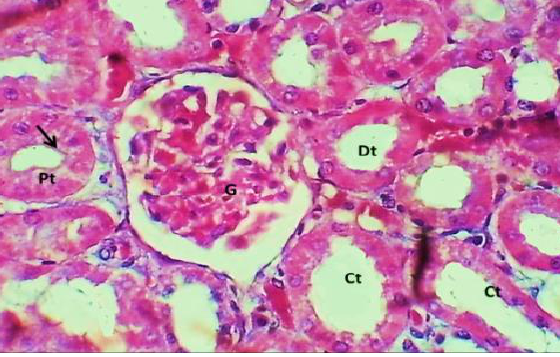
Figure, 5: Histological section of kidney shows: renal capsule (Arrows). Masson trichrom stain. 100x.